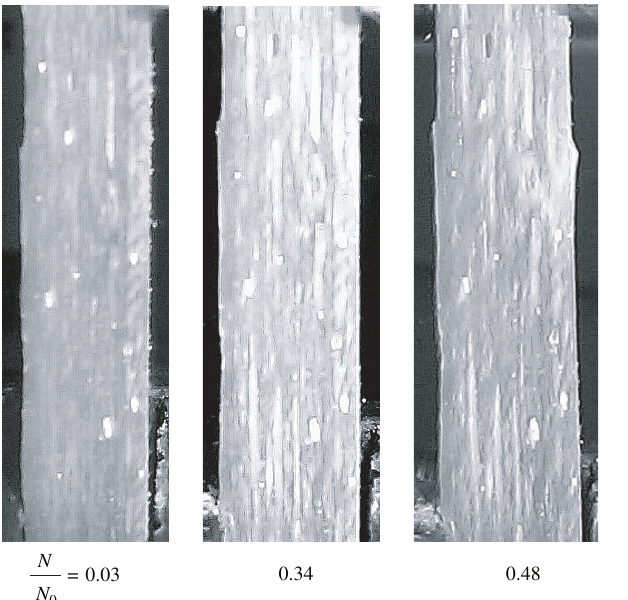
Figure 9. Damage sequence for laminate C12 tested with R = 10 (N = 1460 cycles, σ = 132.8 0 max